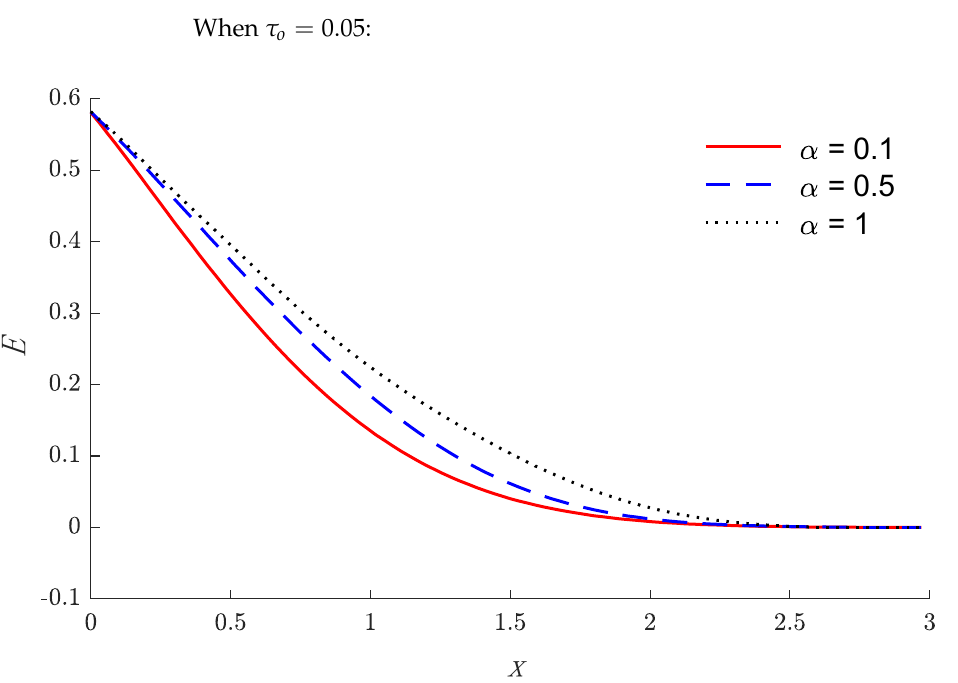
Figure 4. The electric field distributions via the distance x for three values of fractional parameters. When τ o = 0.05 :